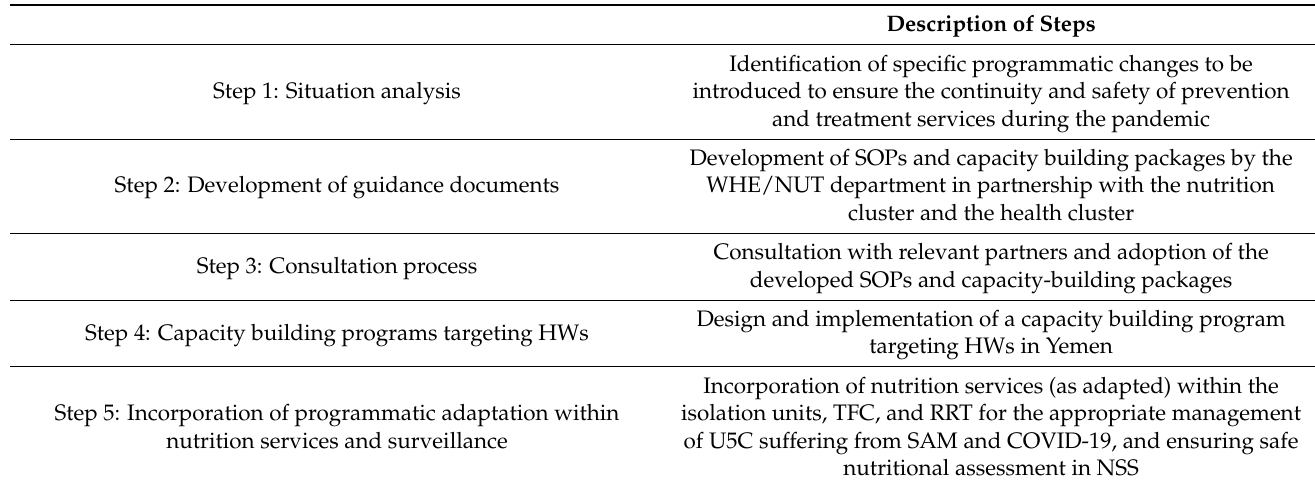
Table 1. A five-step process for the introduction of programmatic adaptations.